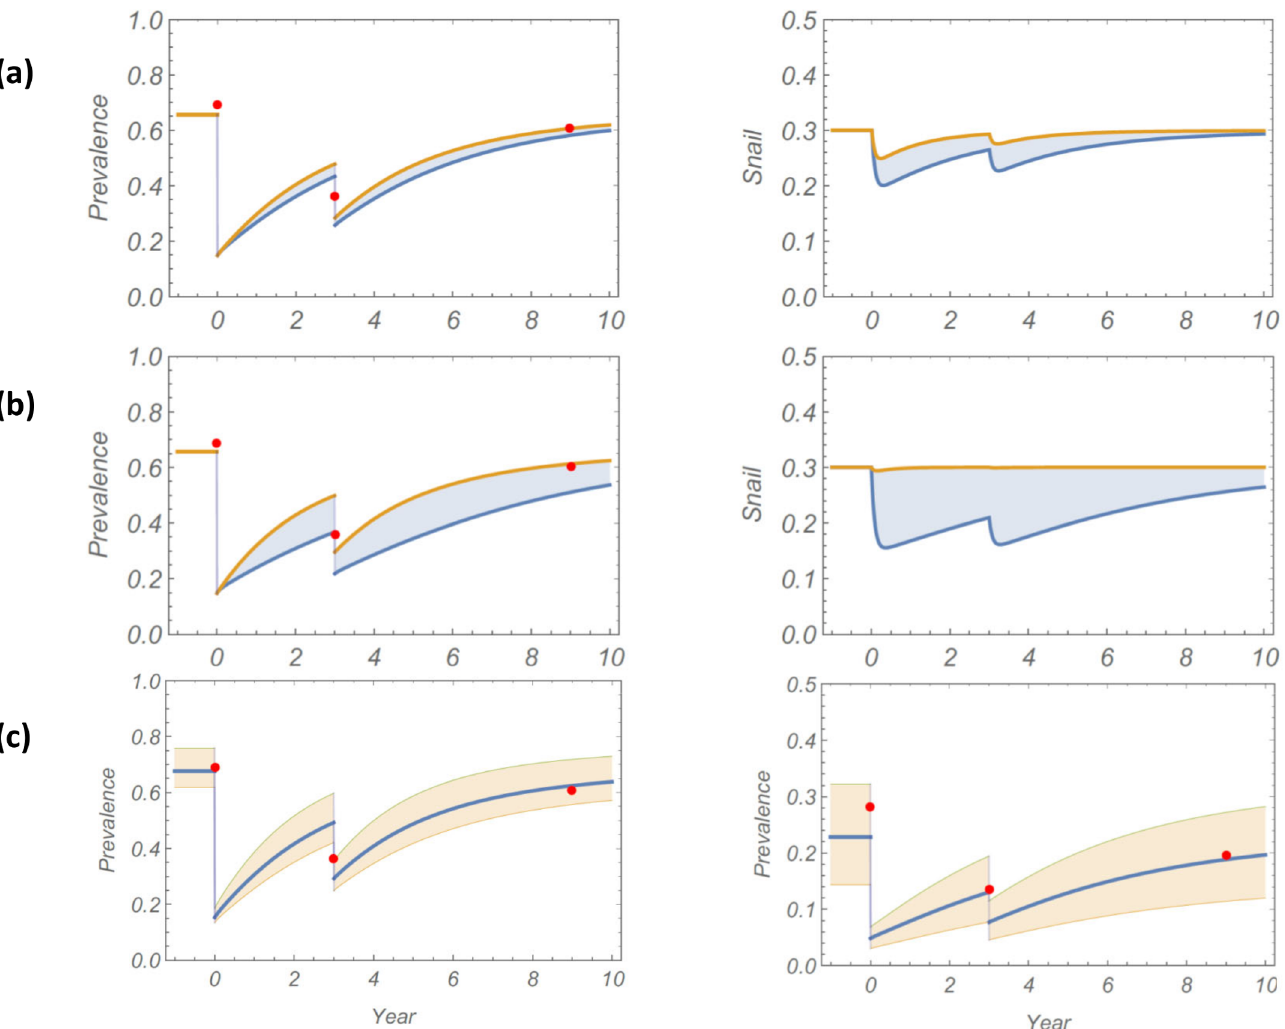
Fig 5. Sensitivity analysis: Solution envelopes and mean history of model M2 for different parameter sampling. Panel (a) the blue shaded regions indicate the full range of predicted outcomes obtained by varying 0.5 < ω < 5, but with fixed b = 1, and the ( λ , ρ , k ) inputs of Table 3. Panel (b) indicates the range of outcomes obtained by varying 0.5 < b < 4, with fixed ω = 1, and the ( λ , ρ , k ) inputs of Table 3. For Panel (c), pink shading indicates the range of outputs with fixed ( ω = 1, b = 1) but with random posterior sampling of ( λ i , ρ i , k i ). Panels (a) and (b) show child (left column) and snail (right column) prevalence histories. Panel (c) shows child (left side) and adult (right side) human prevalence values, respectively. In all cases the observed field data points lie within the prediction